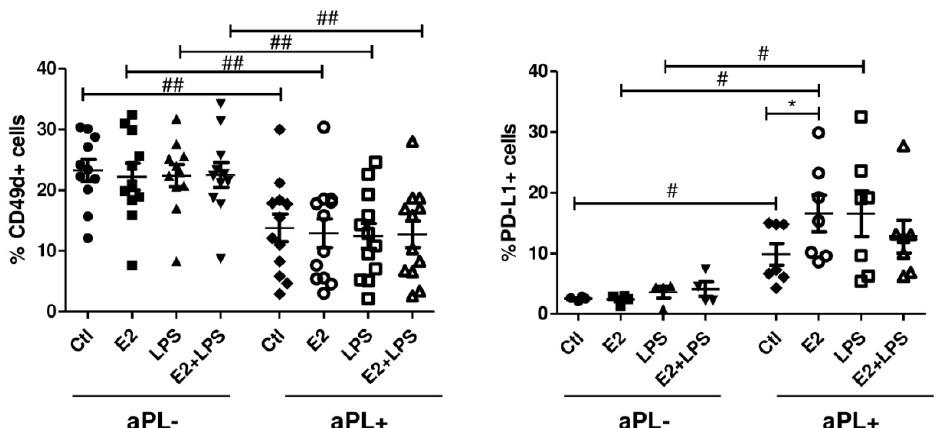
Figure 3. Percentage of CD49d and PD-L1 + B cells in aPL + and aPL- groups. PBMCs were cultured for 24 h in the absence (Ctl) and presence of E2, LPS and E2 + LPS, and analysed by flow cytometry. One-way ANOVA was used to assess statistical significance. The results are shown as mean ± SEM. * ,# p < 0.05, ## p < 0.01.